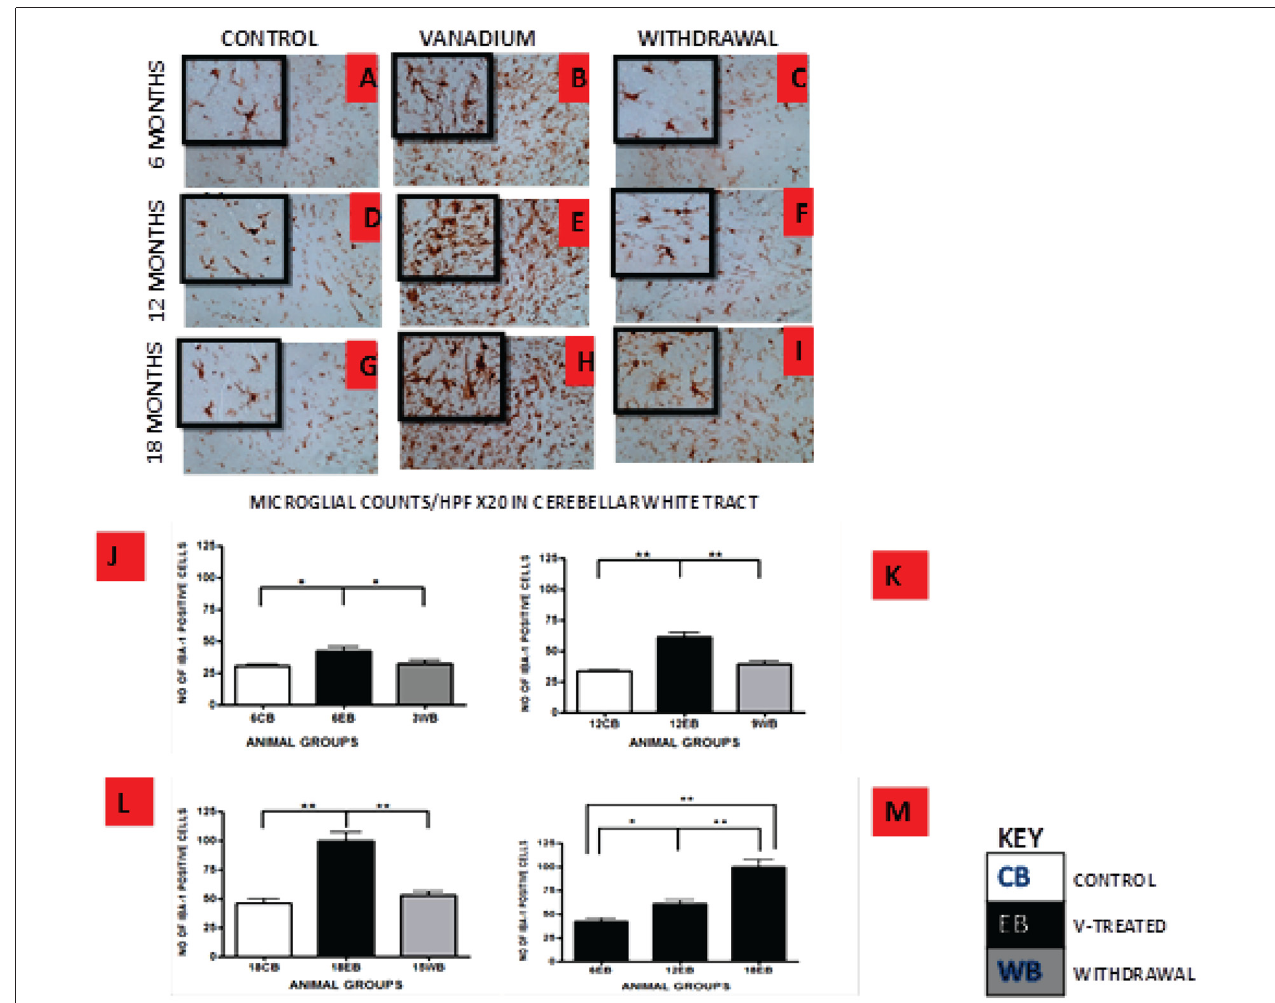
FIGURE 5 | IBA-1 immuno-stained white matter of cerebellum of vanadium exposed (B,E,H) , age matched control (A,D,G) and withdrawal group (C,F,I) mice after intermittent vanadium treatments for 6, 12 and 18 months revealed microglial activation identified by an enlarged cell body with several short, thickened processes, relative to the matched controls with longer, finer branches while the withdrawal groups showed better morphology relative to vanadium exposed groups. (J–L) The number of IBA-1 positive cells in hippocampal CA1 region, and cerebellum were significantly increased in all the vanadium exposed groups compared to controls, while the withdrawal groups showed reversal effect. Persistent microglia activation throughout the exposure increases to phagocytic state indicated by amoeboid isoform. (B,E,H) Microglia activation increases into advanced age with increasing vanadium exposure ( M ; 6EB vs. 18EB = ∗∗ p < 0.01), (ANOVA: ∗ P < 0.05, ∗∗ p < 0.01). Magnification: × 200 inset: ×